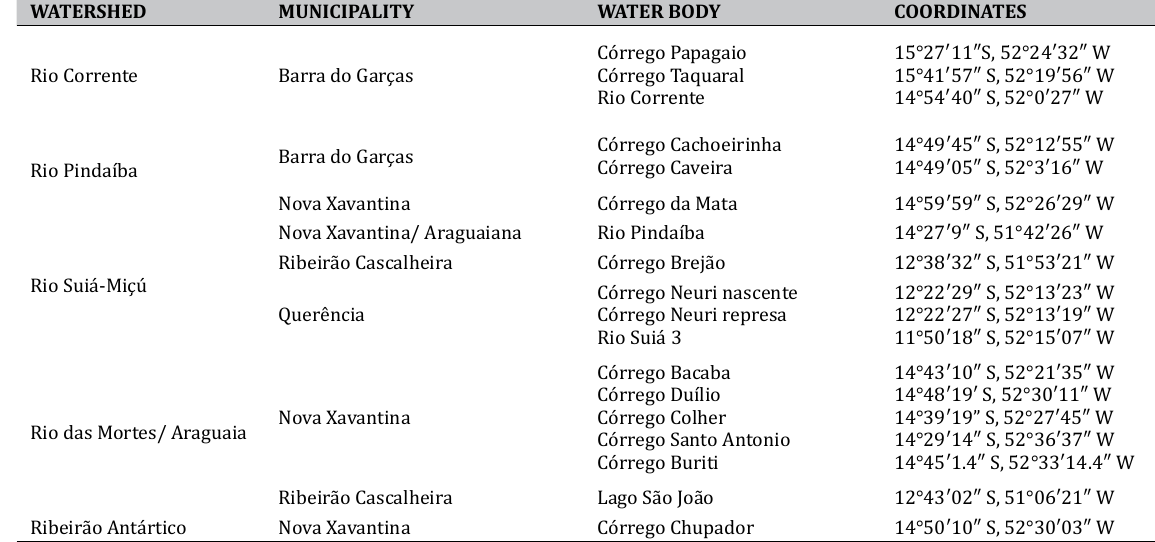
Table 1. List of watersheds with water bodies where specimens were collected, its respective municipalities and